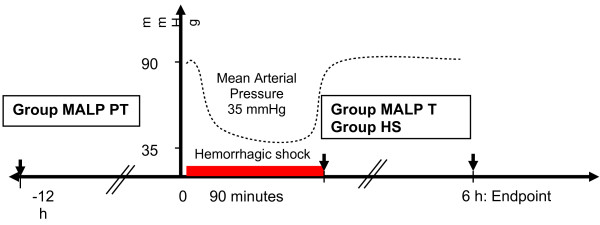
Study design of experiment. Animals were subjected into three treatment groups (n=6). Group HS (Hemorrhagic Shock) received 100 μl (intraperitoneal (i.p.) injection of phosphate buffered saline (PBS) 90 minutes after induction of HS, Group MALP T (Treatment) received an i.p. injection of MALP-2 (4 μg/kg BW) dissolved in 100 μl of PBS after the induction of HS, and Group MALP PT (Pre-Treatment) received an i.p. pre-treatment of MALP-2 twelve hours prior the initiation of HS. Mice were sacrificed 6 hours following HS.